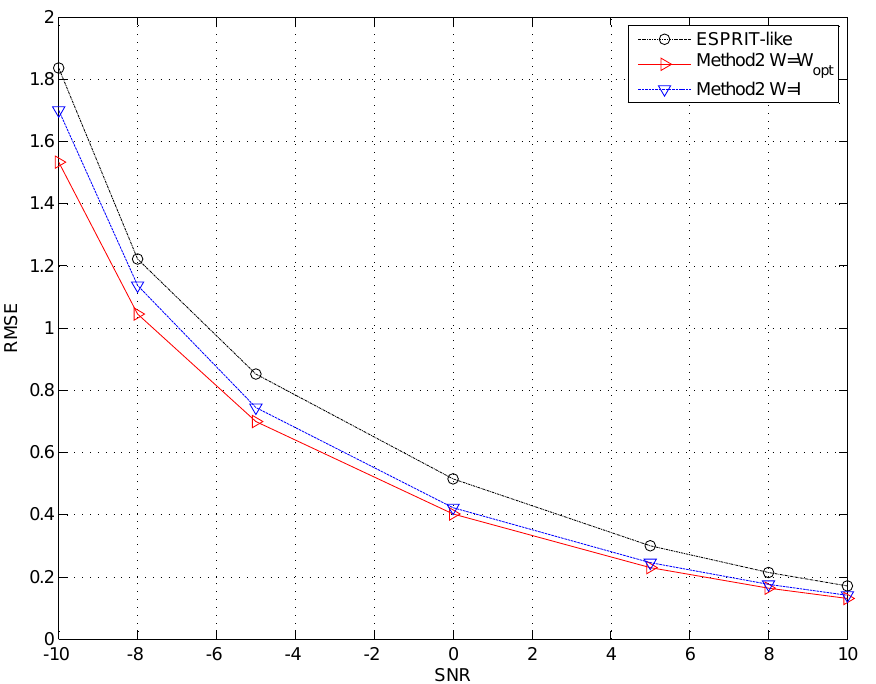
Figure 3. RMSE of the spatial signature matrix V estimation versus SNR with different W . The number of snapshots N = 500